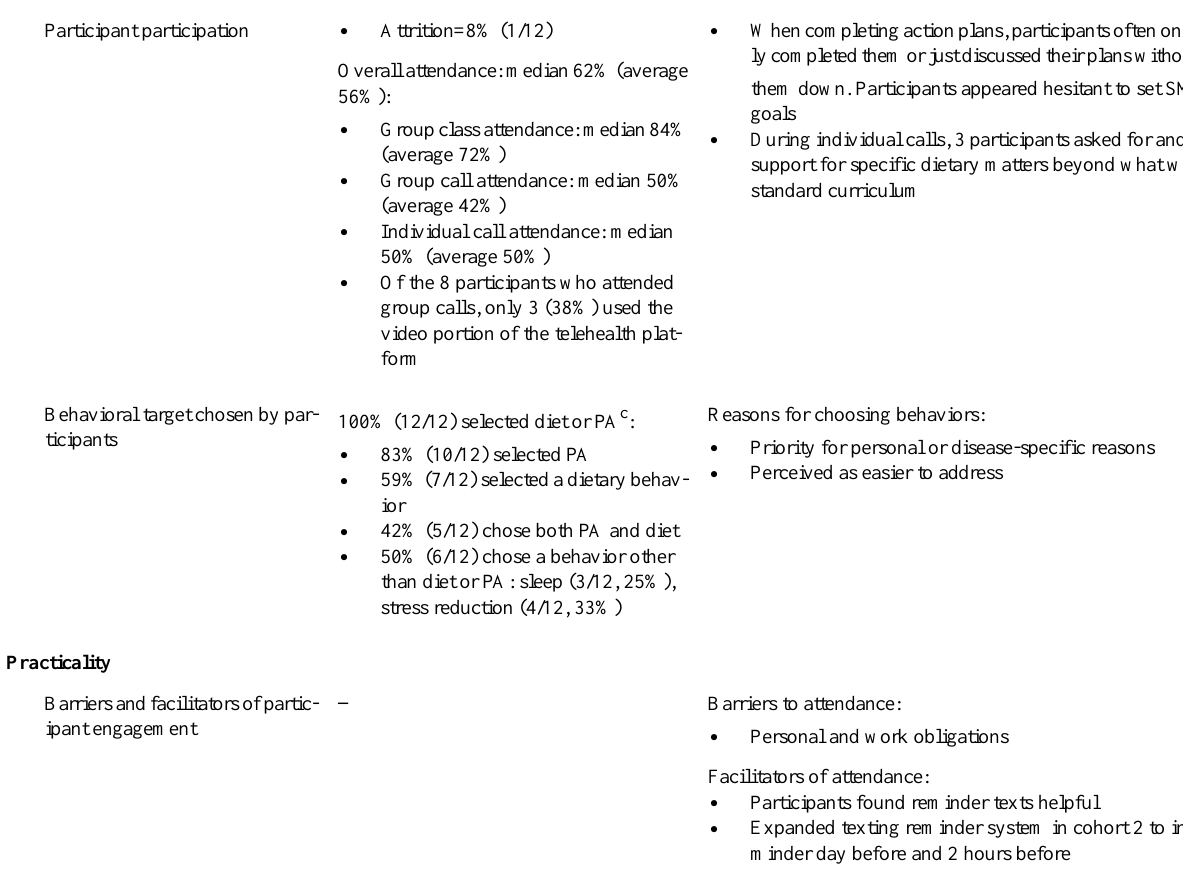
Qualitative findingsQuantitative findingsFeasibility domain and indicator